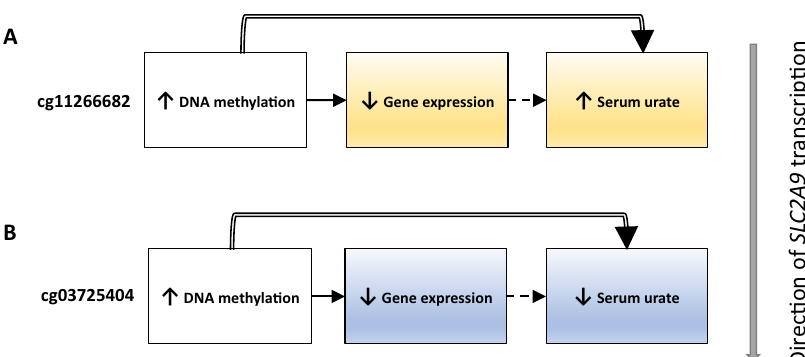
Fig. 5 Conceptual fi gure summarizing patterns of relationships between DNA methylation at SLC2A9 , its expression in monocytes, and serum urate levels. The fi gure focuses on the two CpGs with signi fi cant causal effects on serum urate and association with gene expression in monocytes. The inferred relationship between gene expression and serum urate levels is inverse for the promoter-associated CpG cg11266682 ( A , orange shading), and concordant for CpG cg03725404 ( B , blue shading). Solid compound arrows indicate both observed cross-sectional association and causal effect of DNA methylation on serum urate based on Mendelian randomization analysis. Solid arrows indicate observed cross-sectional associations. Dashed arrows indicate inferred